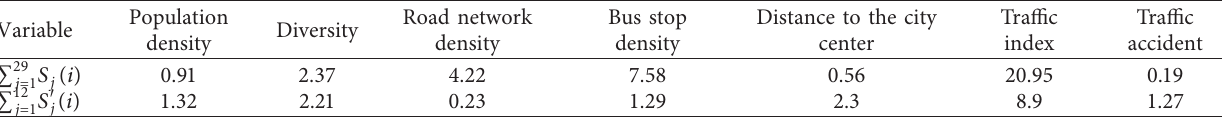
( i ) and S ( i ) of grid whose coordinated development level is j j ′